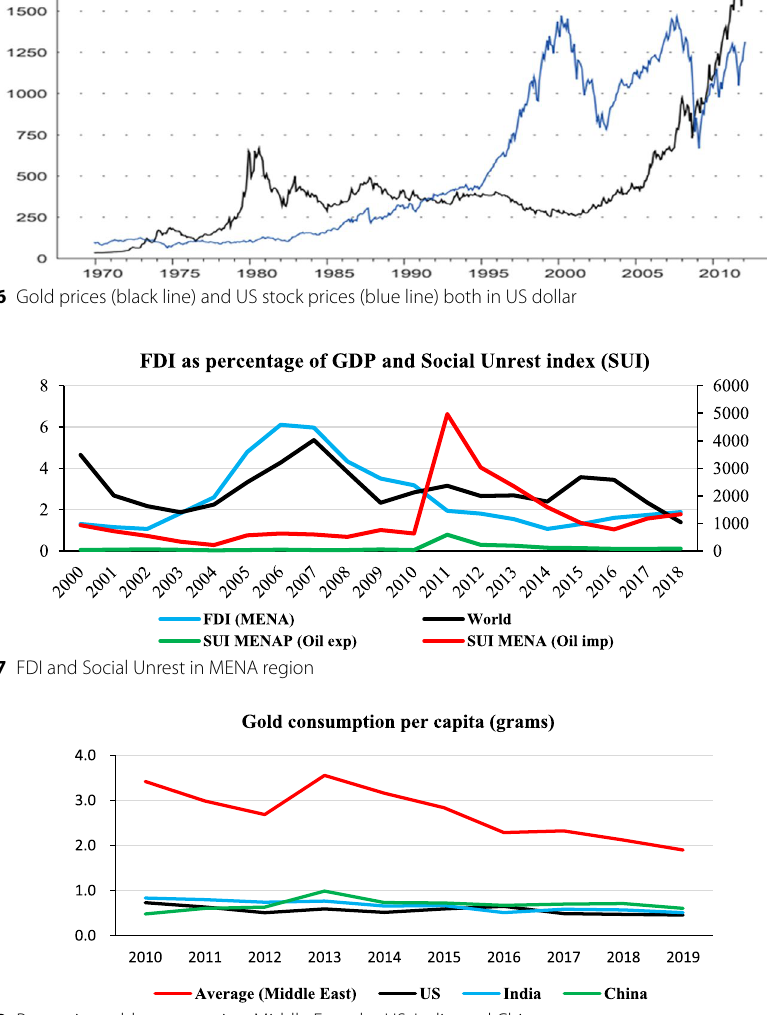
Fig. 8 Per capita gold consumption-Middle East, the US, India, and